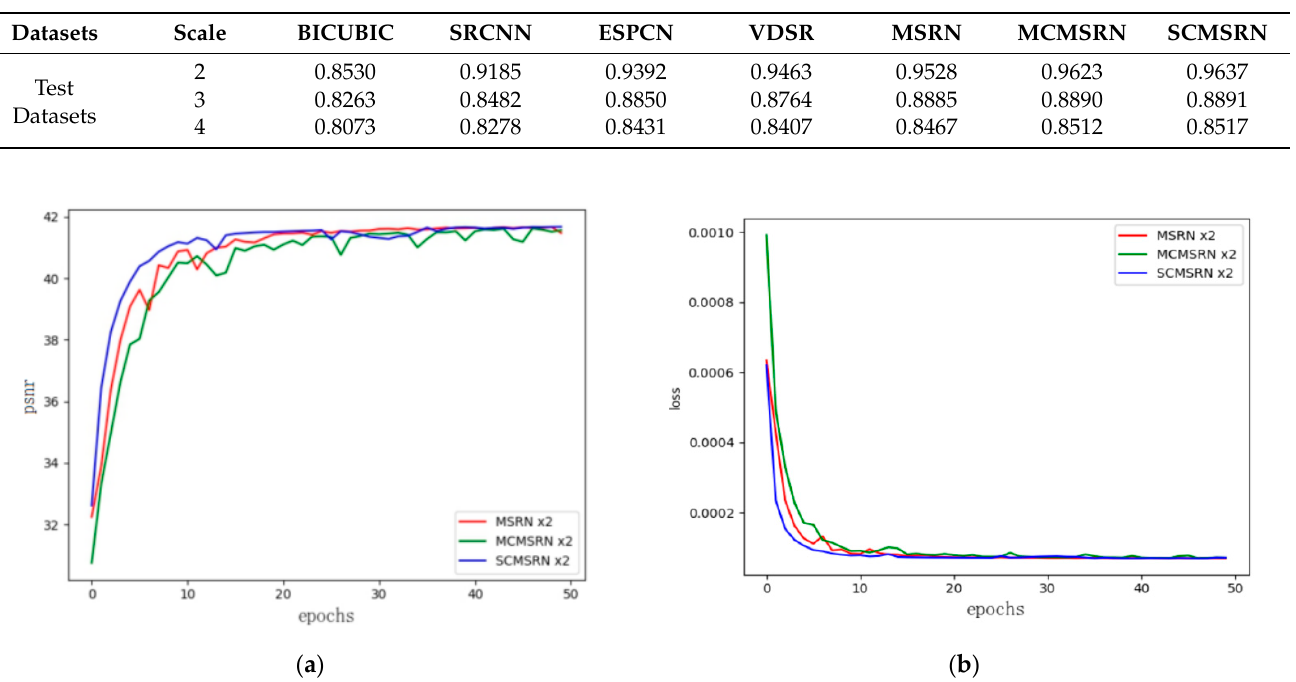
Table 2. SSIM average value of each algorithm on the melt image of liquid metal samples.